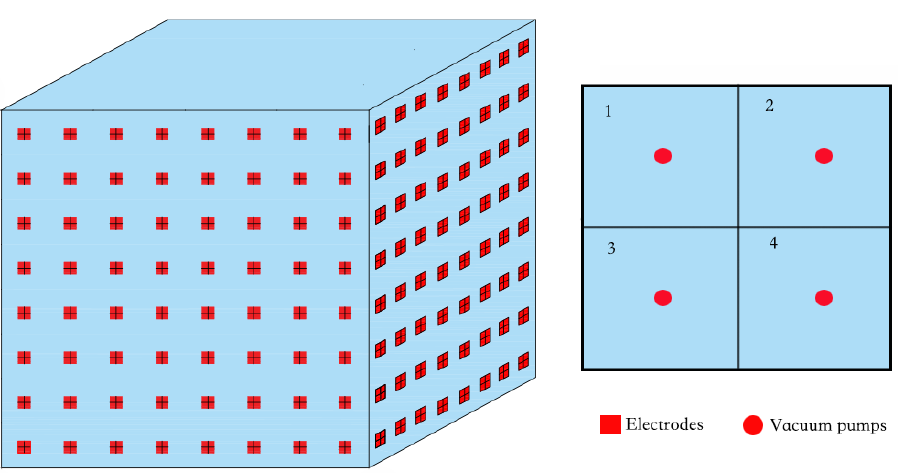
Figure 1. Experimental device design with electrodes and vacuum pumps.